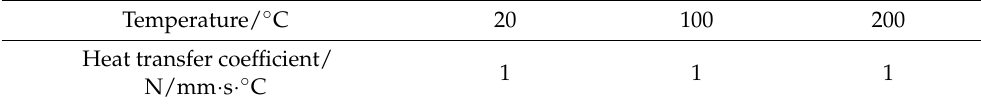
Table 8. Simulated heat transfer coefficient values during air cooling.